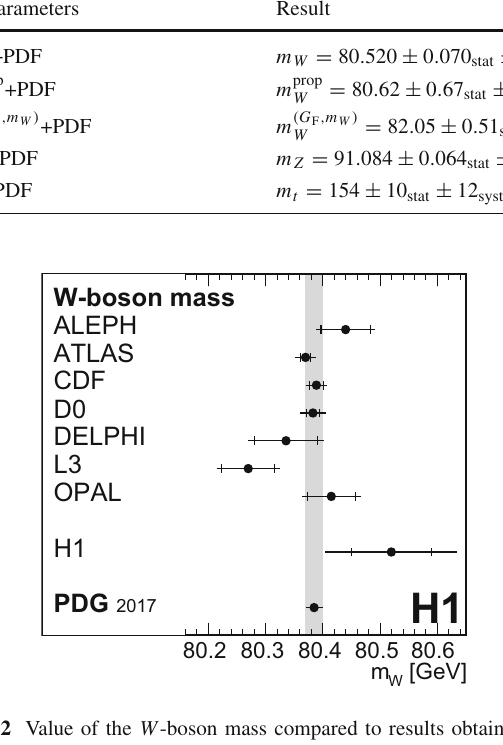
Fig. 2 Value of the W -boson mass compared to results obtained by the ATLAS, ALEPH, CDF, D0, DELPHI, L3 and OPAL experiments, and the world average value. The inner error bars indicate statistical uncertainties and the outer error bars full uncertainties (17)). The highest sensitivity of the H1 data to m W is at a Q